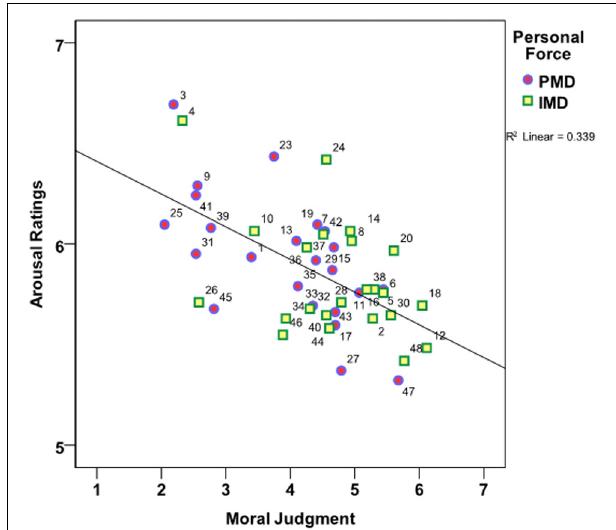
FIGURE 5 | Relationship between level of arousal of a dilemma and the moral judgment made to that dilemma. Color/shape coding: Personal Moral Dilemmas (Blue/Red, circles); Impersonal Moral Dilemmas (Green/Yellow, squares). Mean Likert scale responses: 1 = No, I don’t do it , i.e., deontological moral judgment; 7 = Yes, I do it , i.e., utilitarian moral judgment. Mean Arousal scale responses: 1 = Not arousing, calm ; 7 = Very arousing